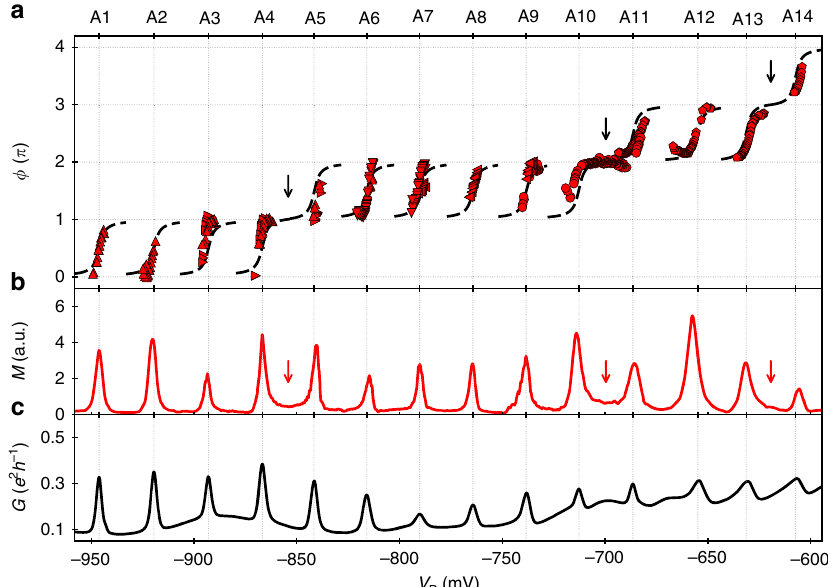
Fig. 4 Transmission phase along 14 resonances. a The red data points show the transmission phase, ϕ , measured along the resonances A1 – A14. The arrows indicate phase plateaus. A guide to the eye is shown as dashed line. It is constructed from electrical conductance, G (Supplementary Note 1). The data alignment procedure is described in Supplementary Note 2. b The magnitude of the AB oscillation, M , is illustrated as red line. The red arrows indicate regions of enhanced AB oscillation. c The electrical conductance at the lower terminal of the interferometer, G = I ↓ / V SD , is shown as black line